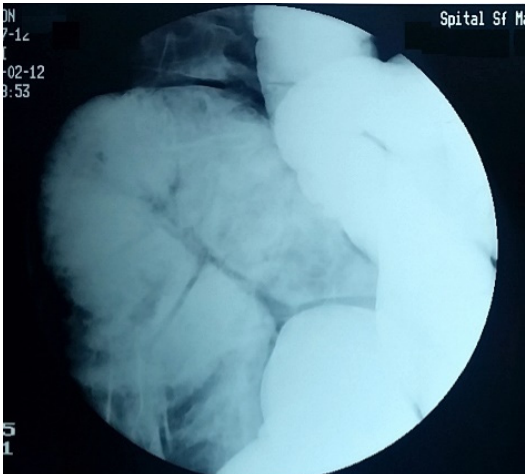
Figure 3. Colon with impressive length, with multiple volutes and important dilation.